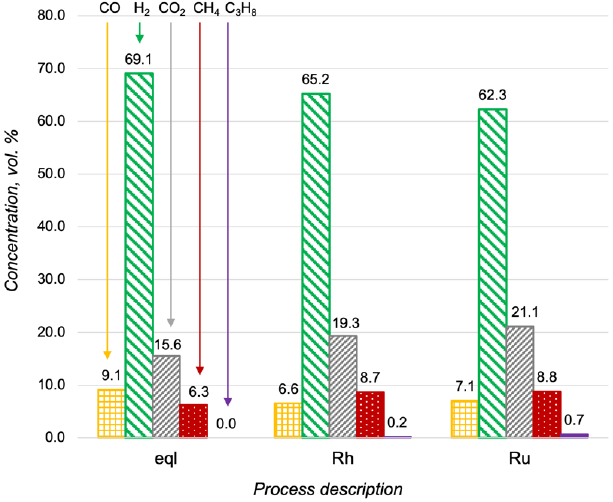
Figure 5. Product distribution in the propane steam reforming at 600 °C, with H 2 O/C = 3 and a flow